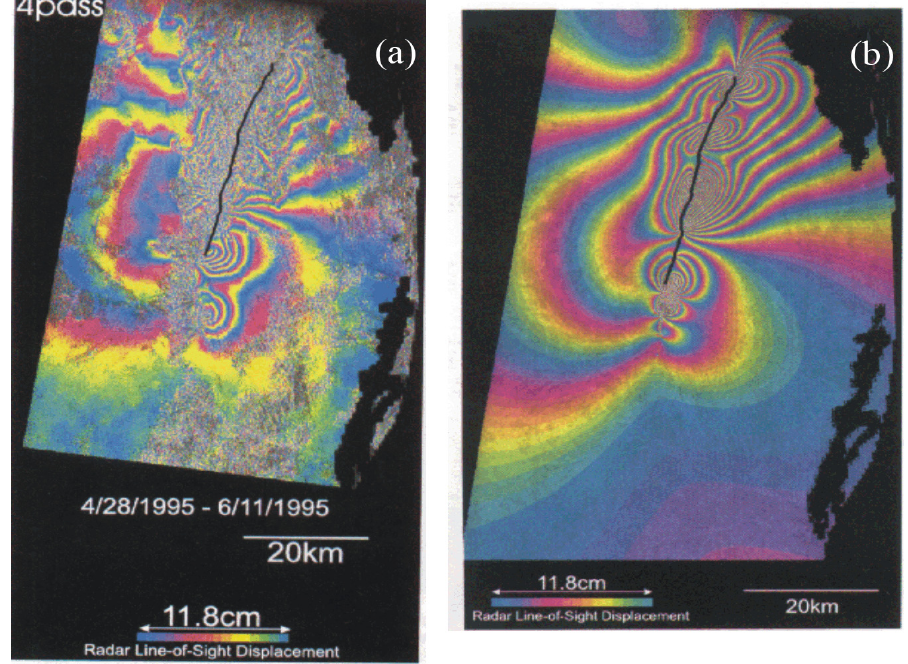
Figure 5. Ground deformations induced by the Neftegorsk earthquake (M = 7.6, 28 May 1995, Sakhalin, Russia). (a) Radar interferogram. (b) Deformation model prediction [18].